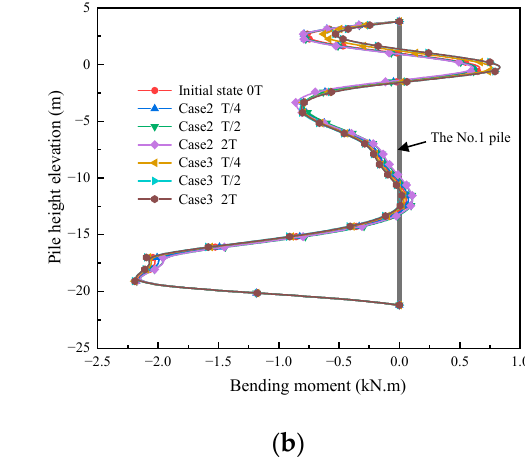
Bending moment (kN.m)